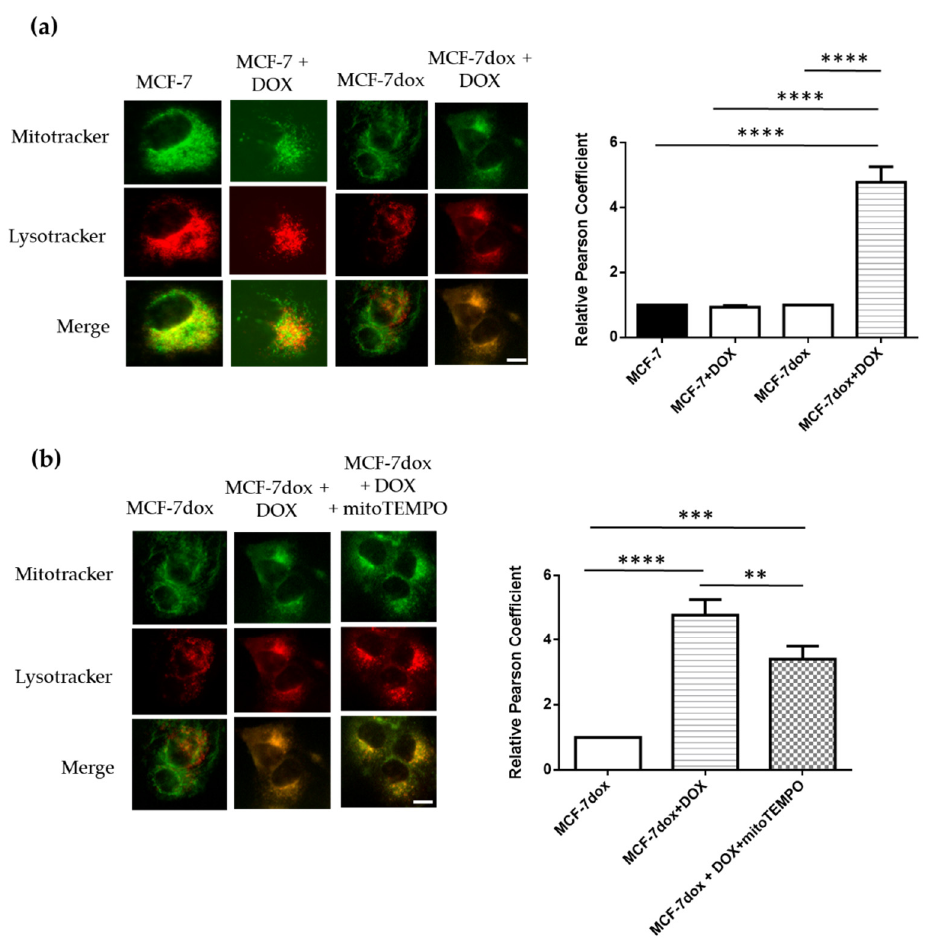
Figure 4. Autophagolysosome formation is activated by DOX treatment in DOX-resistant breast cancer cells. ( a , b ) Representative images of colocalization of lysosomes and mitochondria in MCF-7 and MCF-7dox (scale bar, 10 µ m). Cells were co-stained with 60 nM MitoTracker Green and 100 nM LysoTracker Red for 45 min. Images of cells were acquired with fluorescence microscopy (Nikon eclipse Ti, Okolab) and Nikon’s NIS-Elements microscope imaging software. MCF-7 and MCF-7dox were treated with 100 nM and 30 µ M of DOX, respectively (IC 50 for each cell line), and 5 µ M mitoTEMPO 24 h before the experiment. The colocalization of lysosomes and mitochondria was calculated using image-J software, and Pearson’s correlation coefficient (r) has been applied for quantifying colocalization. A total of 32–49 cells from five independent experiments. The data are presented as mean ± SEM. ** p < 0.01, *** p < 0.005, **** p <